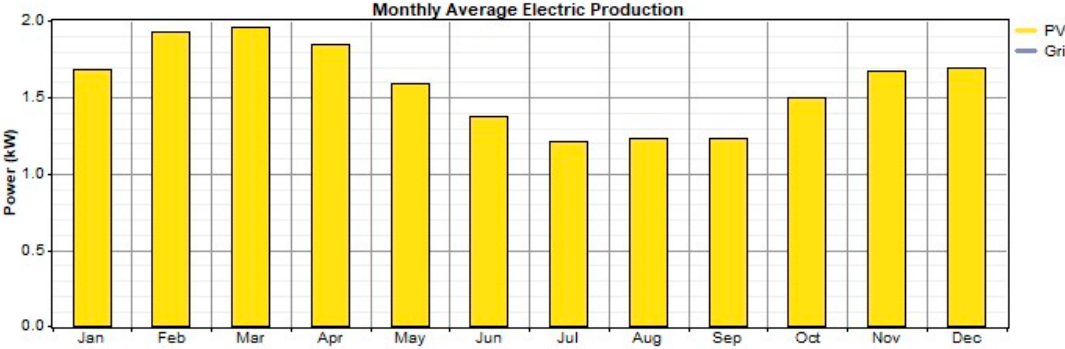
Figure 7. Monthly average electricity production by the system.